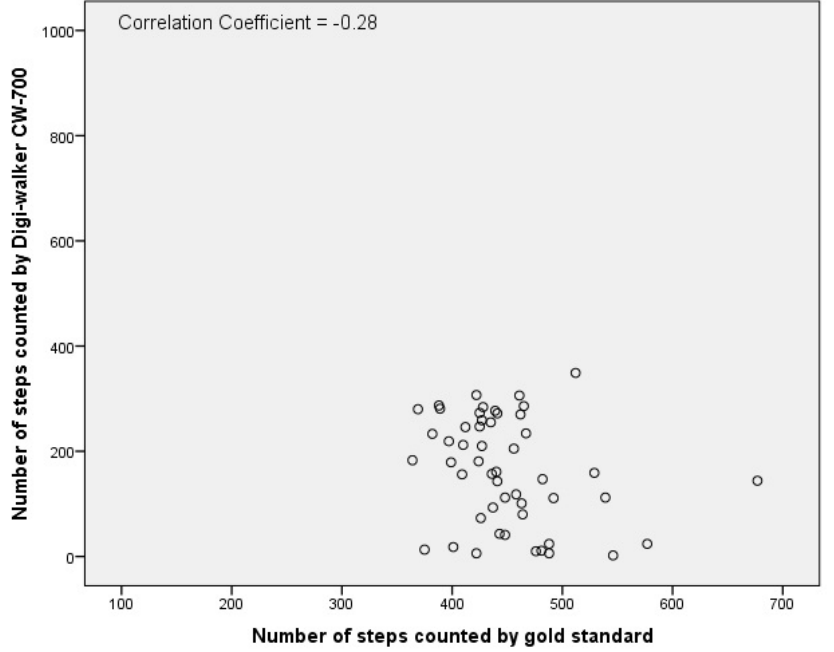
Figure 3. Scatterplot of the number of steps counted by Digi-walker CW-700 and the gold